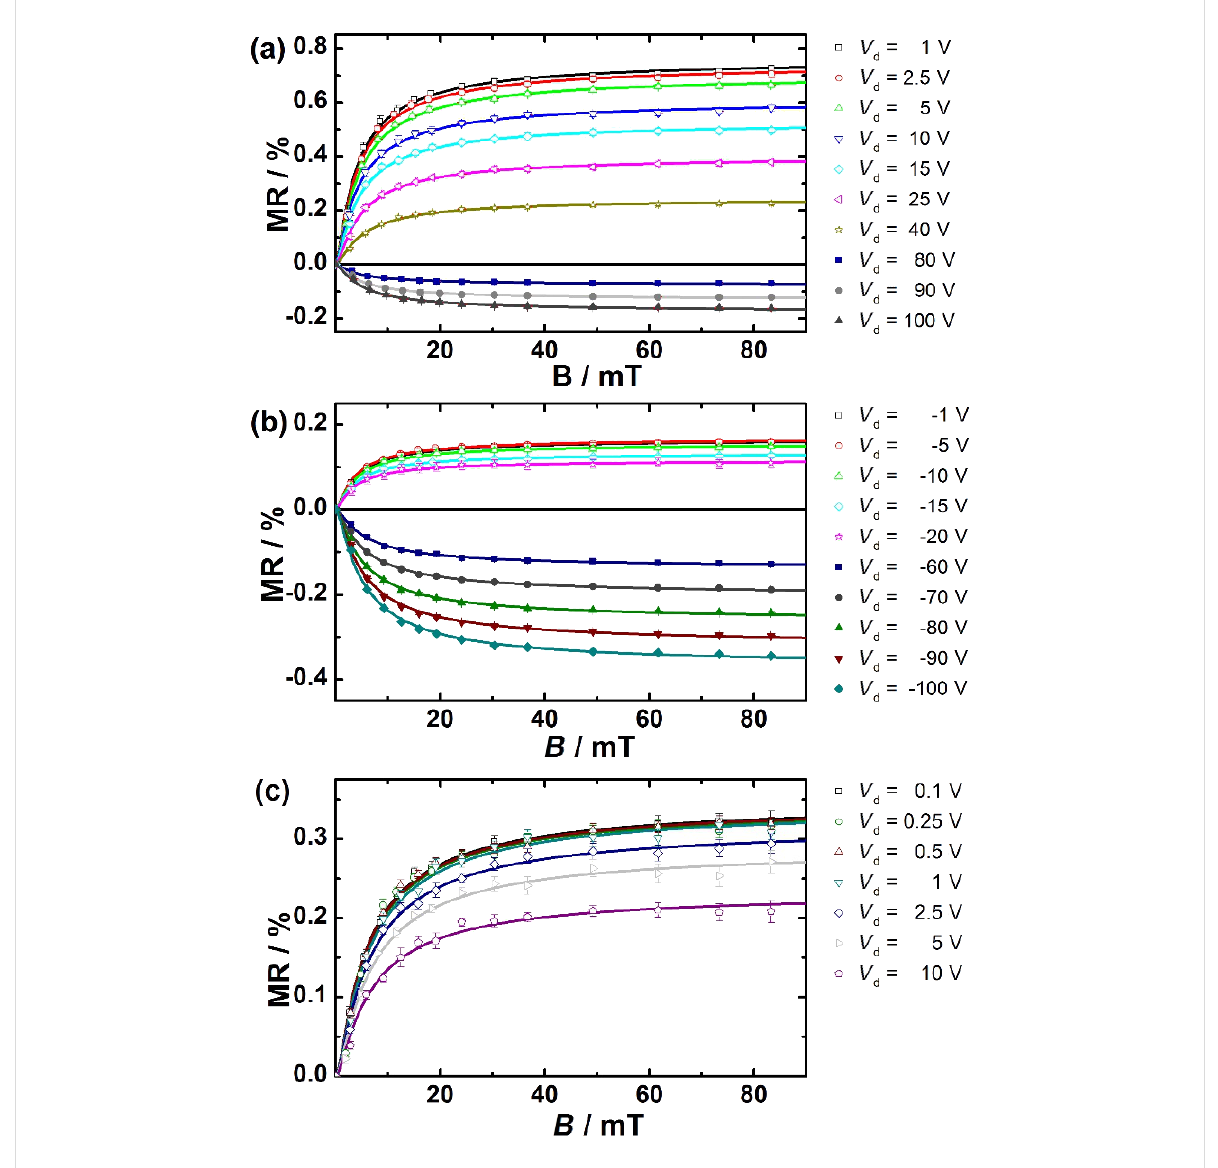
Figure 5: The dependence of the MR line shape curves on the drain voltage V d is shown for a mixing ratio of (a) 51:49, (b) 78:22 and (c) 21:79. All measurements were performed at V g fixed at zero voltage.